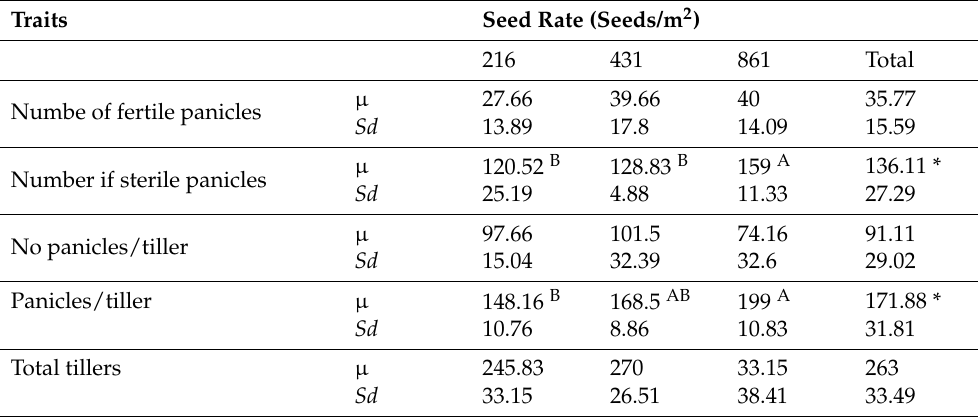
Table 2. Evaluating different levels of male-sterile seed rates on the traits associated with panicles and tillers from year